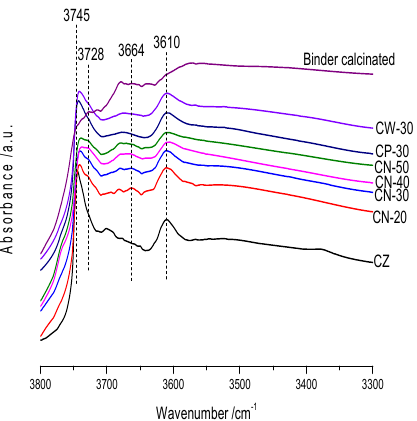
The FT ‐ IR spectra of the catalysts’ surface O ‐ H stretching vibrations are shown in Figure 10. The band at 3745 cm − 1 is related to isolated external silanols [Si ‐ OH] and the shoulder towards lower frequencies (3728 cm − 1 ) has been assigned to weakly interacting internal silanols, while the band at 3610 cm − 1 is assigned to B acid sites associated with framework aluminum [Si ‐ (OH) ‐ Al], typically located at the external surface. The band at 3500 cm − 1 is related to delocalized hydrogen ‐ bonded groups of lattice defects. The additional weak band located at 3664 cm − 1 is observable at catalysts with the binder, which is assigned to extraframework aluminium (EFAl) species [15,28]. The characteristic peaks of external silanols [Si ‐ OH] (3745 cm − 1 ) and skeleton aluminum [Si ‐ (OH) ‐ Al] (3610 cm − 1 ) on the catalysts are obvious. With the addition of the binder the peak intensity of external silanols [Si ‐ OH] (3745 cm − 1 ) decreases and widens. With an increase in binder content the external silanols [Si ‐ OH] peak widens more severely and the internal silanols shoulder peak (3728 cm − 1 ) appears, which indicates that the silanols become dispersed and more abundant. The framework Al [Si ‐ (OH) ‐ Al] (3610 cm − 1 ) peak remained on the formed catalyst. When the binder content reached 40% the peak of 3610 cm − 1 was significantly widened. The [Si ‐ (OH) ‐ Al] (3610 cm − 1 ) peaks of CN ‐ 30, CP ‐ 30 and CW ‐ 30 have little difference, and the peak distribution of the external silanols [Si ‐ OH] (3745 cm − 1 ) of CP ‐ 30 is more concentrated, followed by CW ‐ 30. The peak distribution of the external silanols [Si ‐ OH] (3745 cm − 1 ) of CN ‐ 30 is wider than that of CP ‐ 30 and CW ‐ 30, indicating that the addition of dilute nitric acid is conducive to enhancing the interaction between the binder and HZSM ‐ 5 zeolites.